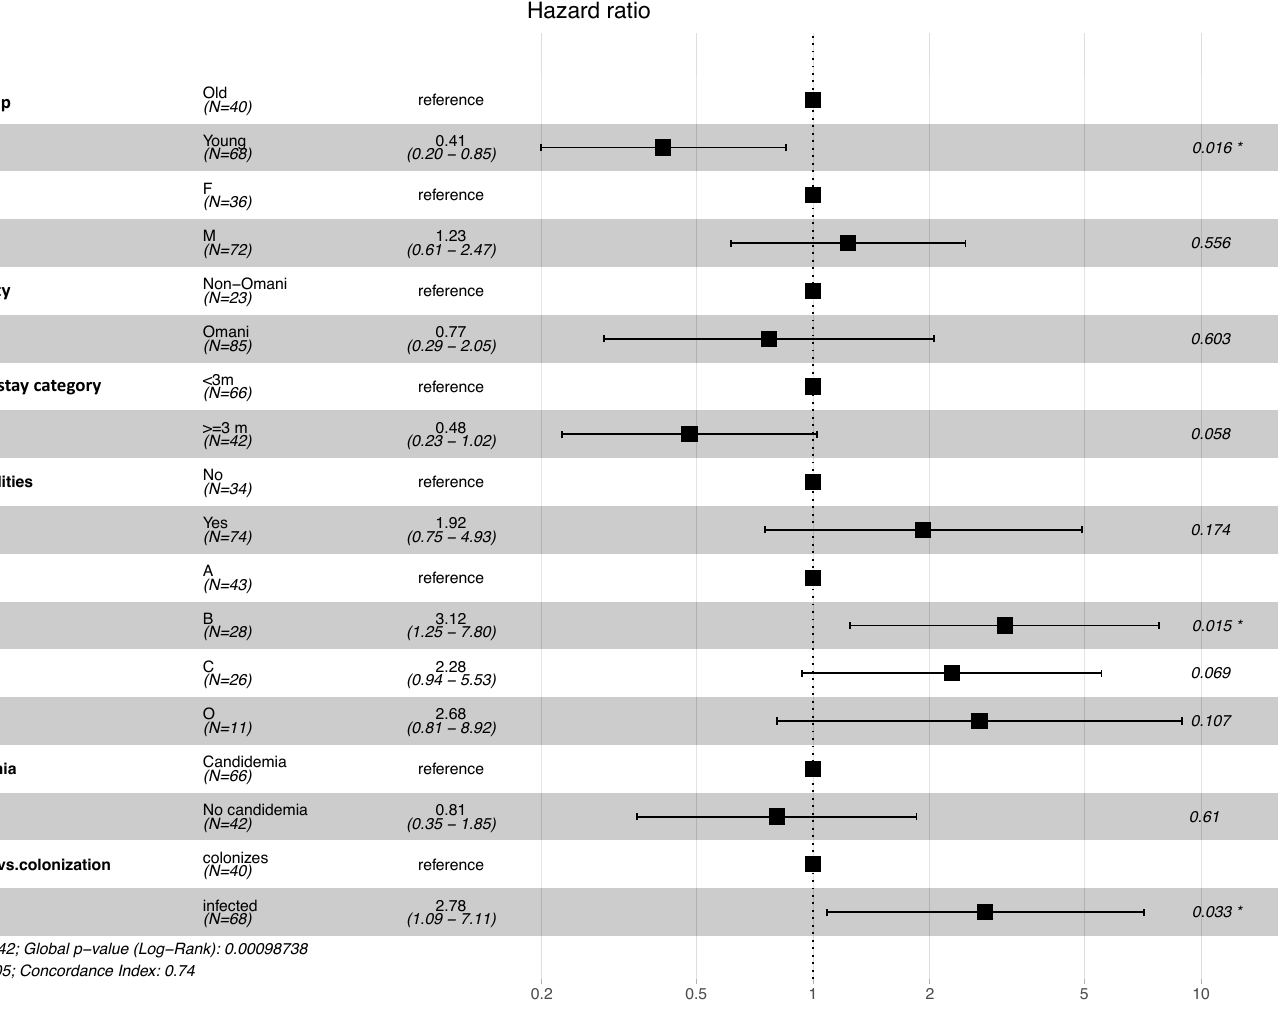
Figure 3. Multivariate Cox proportional hazard model for survival post diagnosis by age, sex, nationality, length of stay, presence of comorbidities, hospital where patients were admitted, candidemia, and colonization vs. infection. Column 3 represent the hazard ratio (95% confidence interval), * statistically significant, p value <